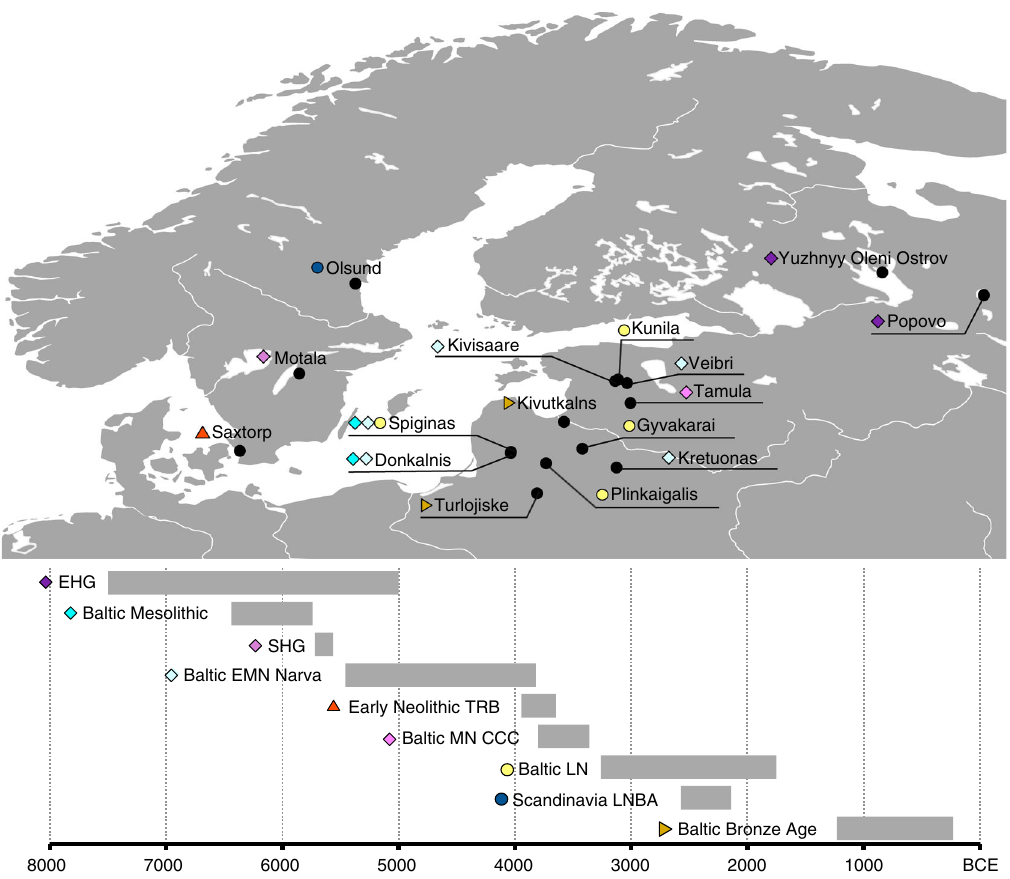
Fig. 1 Sampling locations and dating of 38 ancient Northern European samples introduced in this study. Chronology based on calibrated radiocarbon dates or relative dating, see Supplementary Note 2. Map generated with QGIS 2.18.2 (http://www.qgis.org/) using the Natural Earth data set (http://www. naturalearthdata.com) for the The 38 fi nal samples fall into nine broad groups (Table 1): fi rst, two Mesolithic hunter-gatherers from north-western Russia (ca.